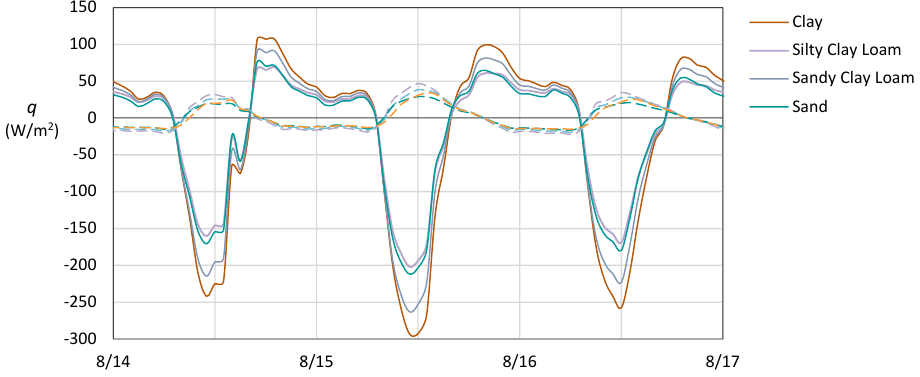
Figure 4. Effect of soil texture on patterns of latent heat flux q L (dashed lines) and sensible heat flux q k (solid lines) at the outer surfaces of horizontal Mexican green roofs, 10 cm in thickness, in the semi-arid steppe climate of Laredo, TX, USA (Köppen BSh , Table 3; Figure 8). Data show hourly values for four of the twelve soils described above (Figure 2) that spanned the range of performance, illustrating the ability of intrinsic evaporative cooling to counteract solar gain. Ambient humidity was the only source of